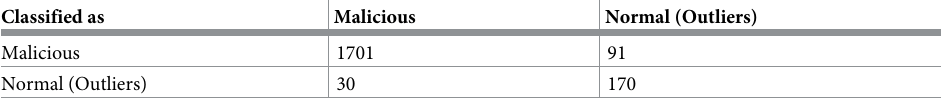
Table 11. Confusion matrix for outlier detection during one-class SVM training—SIP dataset.